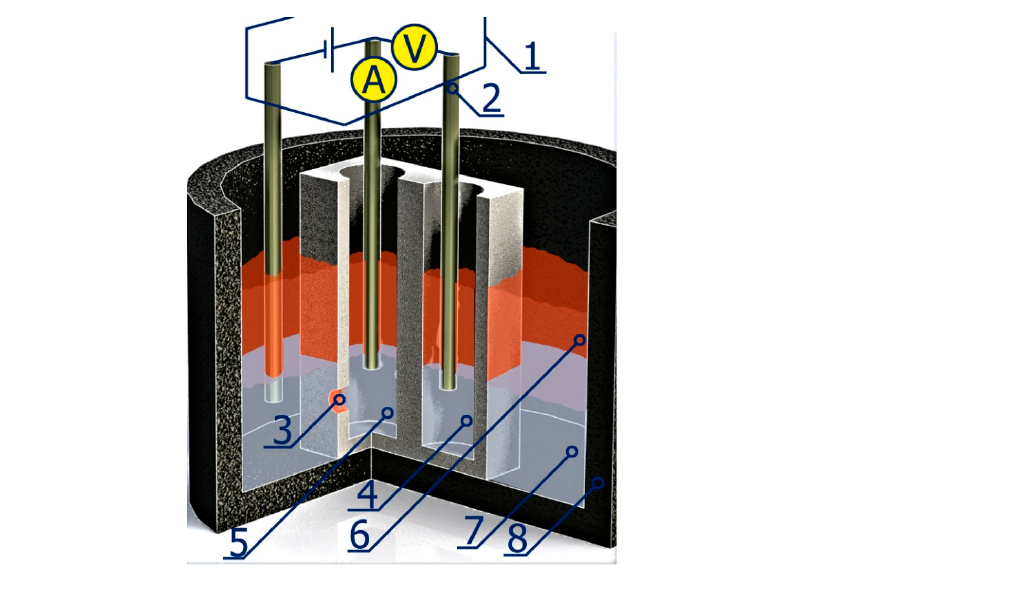
Figure 1. Schematic representation of a single capillary cell: 1—PGSTAT Autolab 302n, 2—tungsten current leads, 3—capillary (0.6 mm diameter, 2.5 mm length) drilled in BN two-electrode set-up, 4— Al/AlF 3 reference electrode, 5—Al working electrode, 6—NaCl–KCl (1:1 molar ratio) + 10 wt.%AlF 3 , 7—Al counter electrode, 8—graphite crucible.